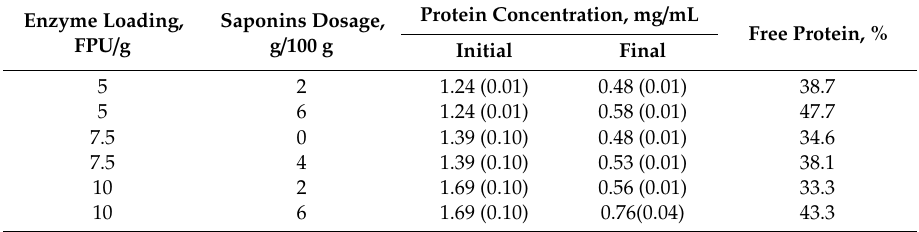
Table 3. Total soluble protein before and after enzymatic hydrolysis of steam-pretreated spruce. Enzyme Loading, FPU / g